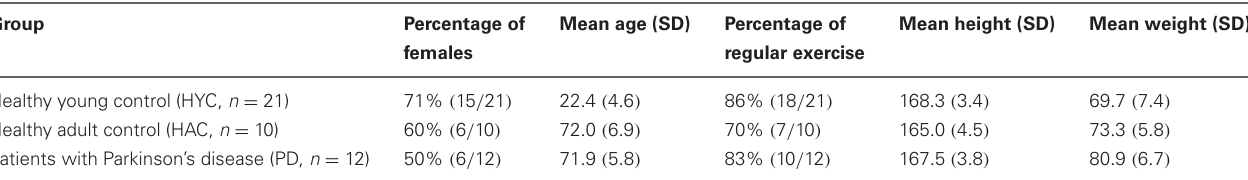
Table 1 | Descriptive parameters of the study population. Group Percentage of Mean age (SD) Percentage of Mean height (SD) Mean weight (SD) females regular exercise Healthy young control (HYC, n = 21) 71% ( 15 / 21 ) Healthy adult control (HAC, n = 10) Patients with Parkinson’s disease (PD, n =